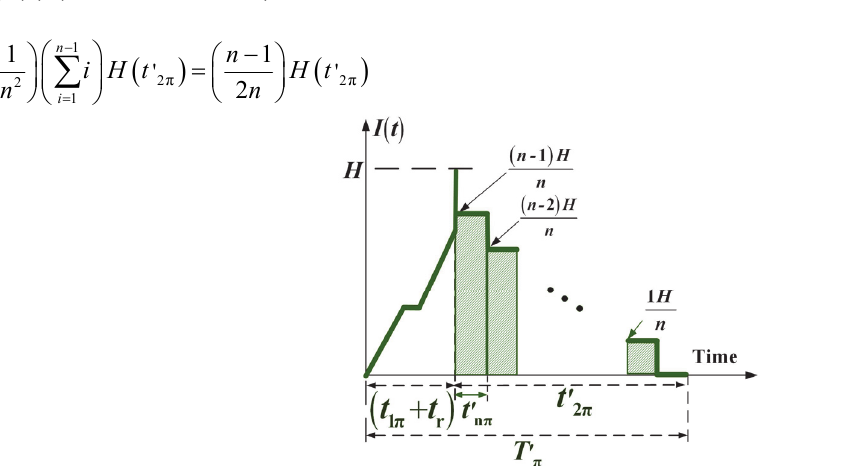
Fig. 4. The finished stock level during t' 2 π in condition 1 of the proposed system